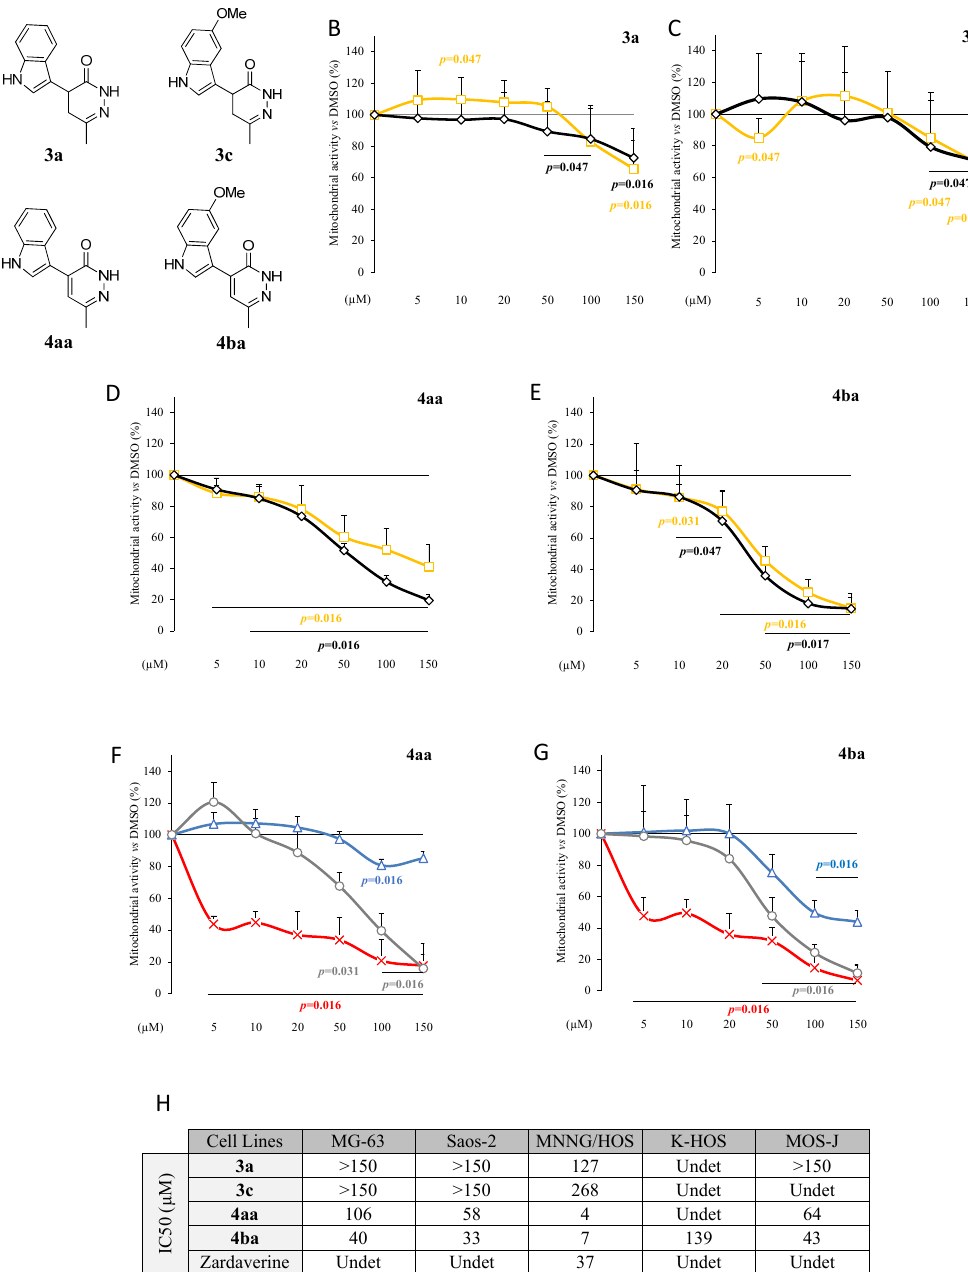
Figure 1. Pyridazinone derivatives exhibit cytotoxic activity. Chemical structure of compounds 3a , 3c , 4aa and 4ba ( A ). Mitochondrial activity versus DMSO on human osteosarcoma cell line Saos-2 (black diamond) and MG-63 (yellow square) after 96 h of treatment with increasing doses of 3a ( B ) and 3c ( C ). Mitochondrial activity versus DMSO on human osteosarcoma cell lines Saos-2 (black diamond) and MG-63 (yellow square) after 96 h of treatment with increasing doses of compounds 4aa ( D ) and 4ba ( E ). Mitochondrial activity versus DMSO on human osteosarcoma cell lines MNNG/HOS (red cross) and K-HOS (blue triangle) and mouse cell line MOS-J (grey circle) after 96 h of treatment with increasing doses of compounds 4aa ( F ) and 4ba ( G ). IC 50 of osteosarcoma cell lines ( H ). Undetermined (Undet) means that the molecule was not efficient enough to determine the IC 50 value. n = 7. p -values are given relative to DMSO.